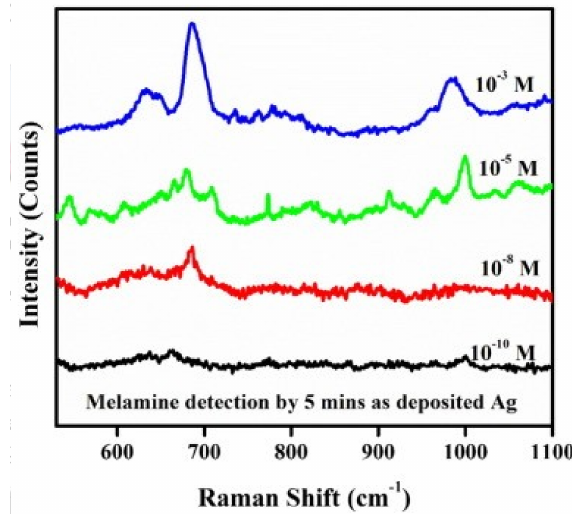
Figure 21. SERS Spectra of Melamine with different concentrations for 5 min Ag deposited samples (reproduced with permission from Reference